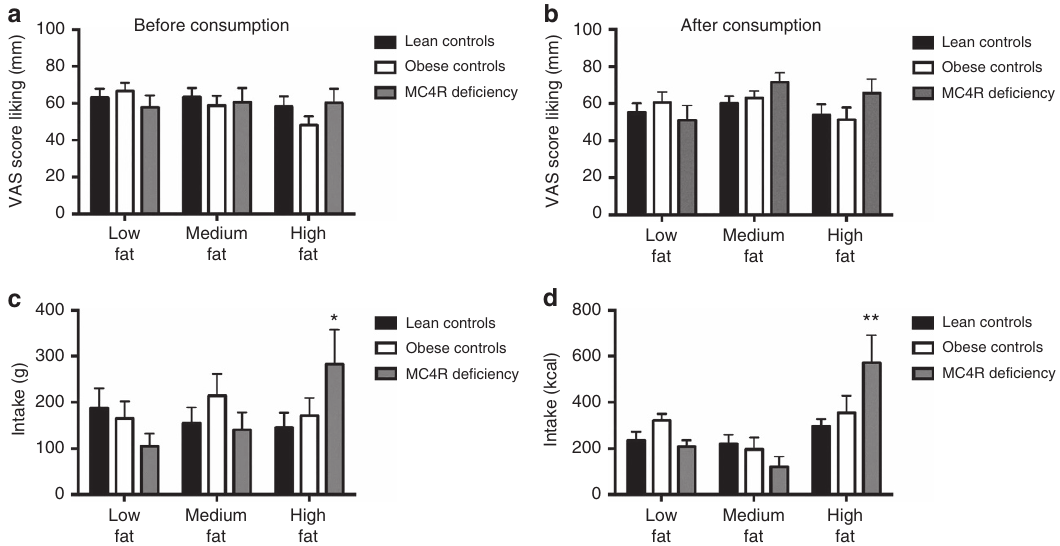
Figure 1 | Liking ratings and food intake in the fat preference test. Liking of low, medium and high fat meals before ( a ) and after ( b ) an ad libitum test meal in lean controls ( n ¼ 20), obese controls ( n ¼ 20) and individuals with MC4R deficiency ( n ¼ 14). No differences were found between the groups or between meals for liking (VAS ¼ visual analogue scales). ( c ). Total intake (g and kcal; c , d respectively) in lean controls, obese controls and individuals with MC4R deficiency. Means ± s.e.m. (error bars) are shown. Results were analysed using ANOVA analysis (with interaction terms for study group and study meal) with Tukey’s HSD post-hoc comparisons. * P ¼ 0.0222 and ** P ¼ 0.023 for the interaction of group by meal.